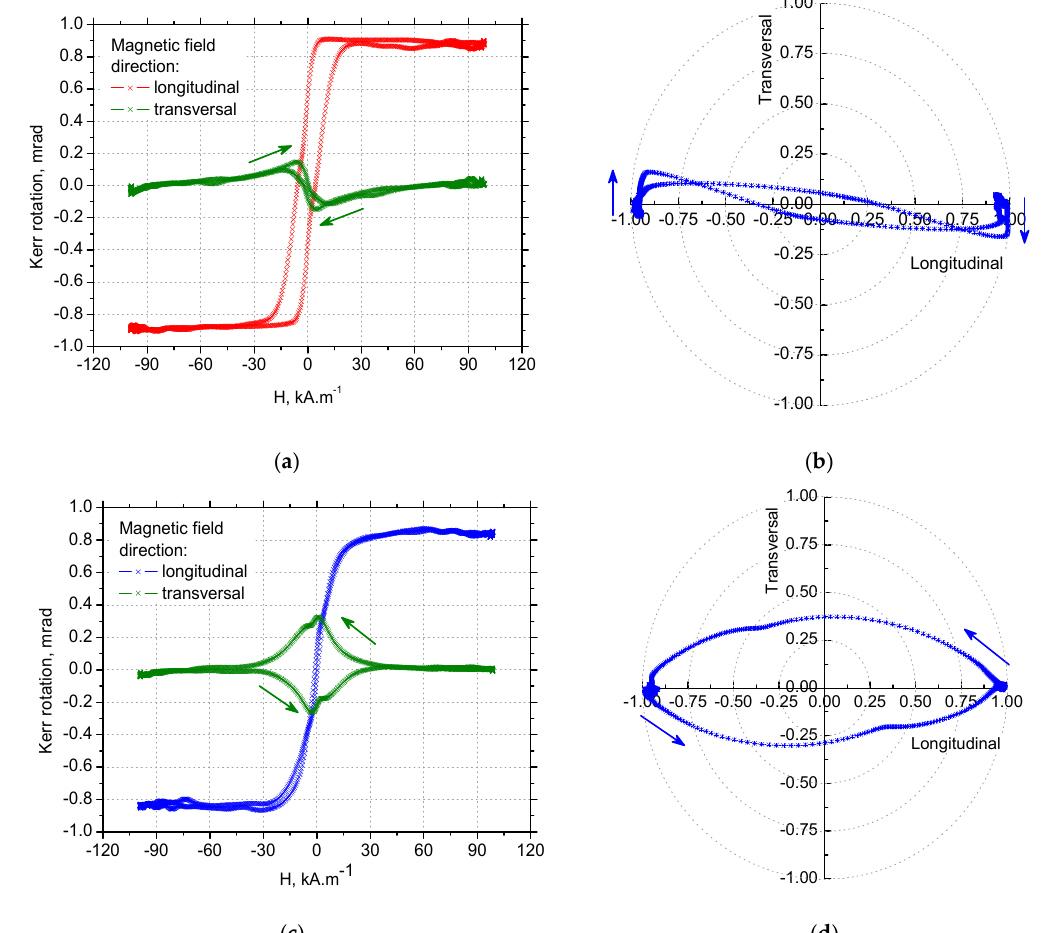
Figure 19. Hysteresis loops and polar graphs for VB = 0.05 mm, normalized: ( a ) hysteresis loops for the tangential direction, ( b ) polar graph for the tangential direction, ( c ) hysteresis loops for the axial direction, and ( d ) polar graph for the axial direction.